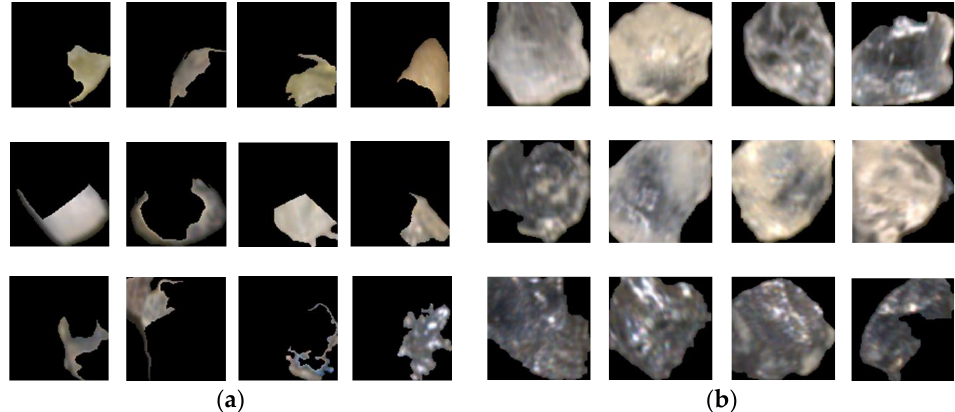
Figure 5. Samples of the outcome of the segmented grains using the method of Maitre et al. [22] ( a ) and our approach ( b ).